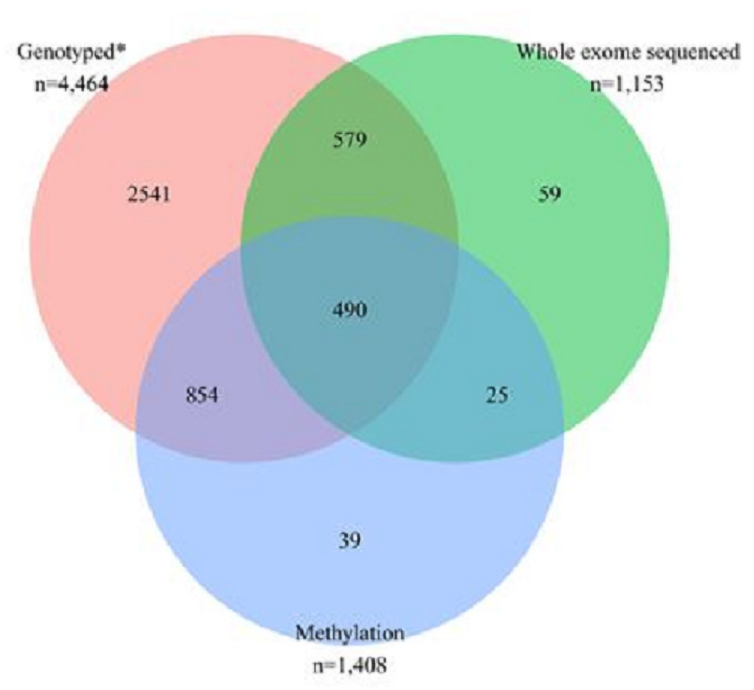
Fig 1. Participants who were genotyped using OncoArray, who were whole exome sequenced using Roche SeqCap EZ Human Exome v3.0, and/or had information on methylation levels measured using Illumina Infinium MethylationEPIC BeadChip. � All patients who were genotyped were part of Breast Cancer Risk after Diagnostic Gene Sequencing (BRIDGES).